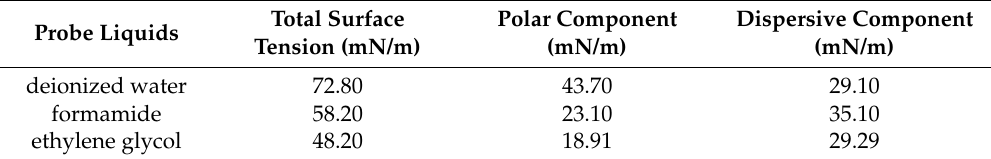
Table 1. Probe liquid for surface free energy (SFE) calculation and their surface tension.